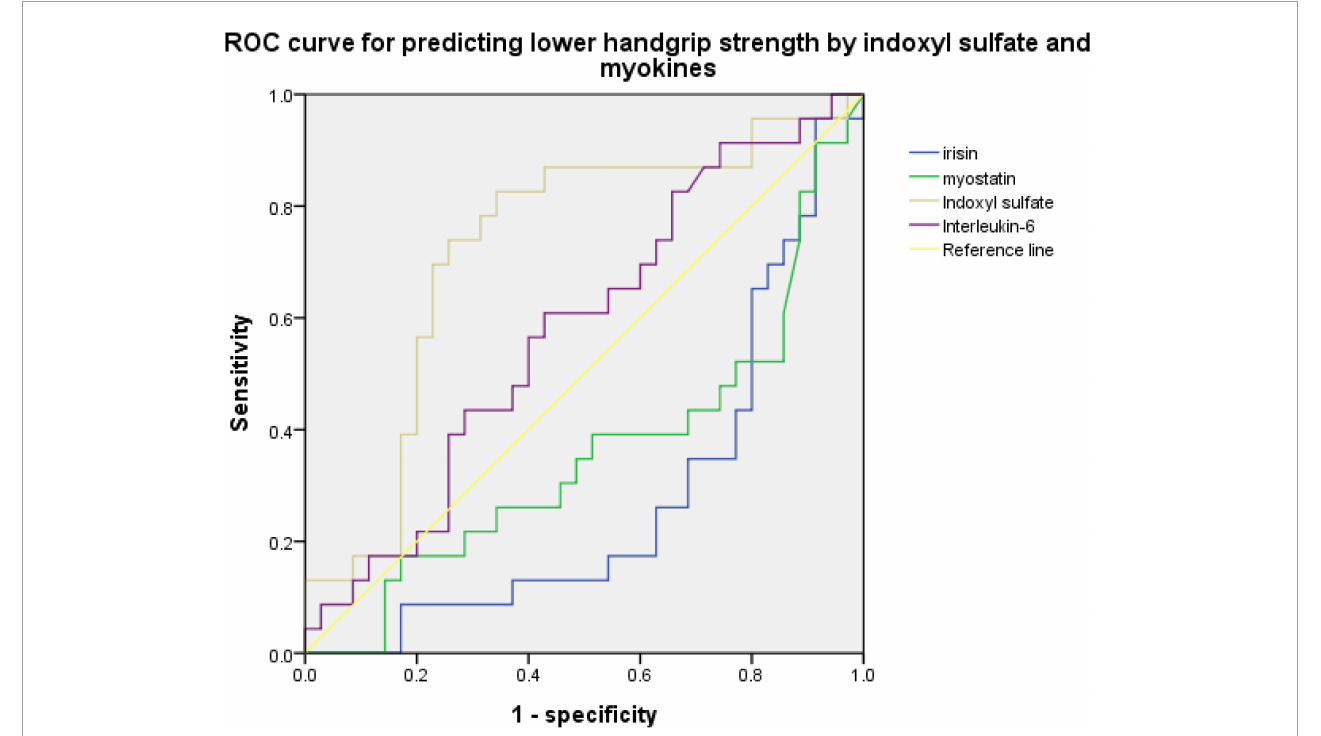
FIGURE3 ROC curve for predicting low handgrip strength based on concentrations of indoxyl sulfate, irisin, myostatin, and interleukin-6 (indoxyl sulfate: AUC: 0.724, 95% CI: 0.585–0.863, p < 0.05; irisin: AUC: 0.276, 95% CI: 0.142–0.410, p < 0.05; myostatin: AUC: 0.358, 95% CI: 0.208–0.508, p < 0.05; interleukin-6: AUC: 0.578, 95% CI: 0.429–0.727, p =